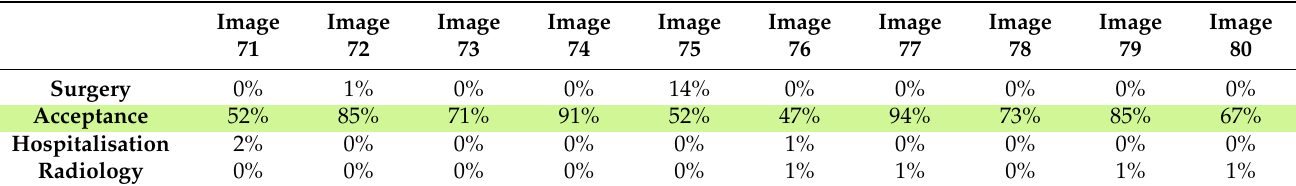
Table 14. Results obtained with the second version of the customised model for the “acceptance” IU. Each column refers to one of the test images (71 to 80) and each row shows the labels that were returned by the model. The row–column intersection shows the success rate in recognising the concept stated in the row for the image in that column.